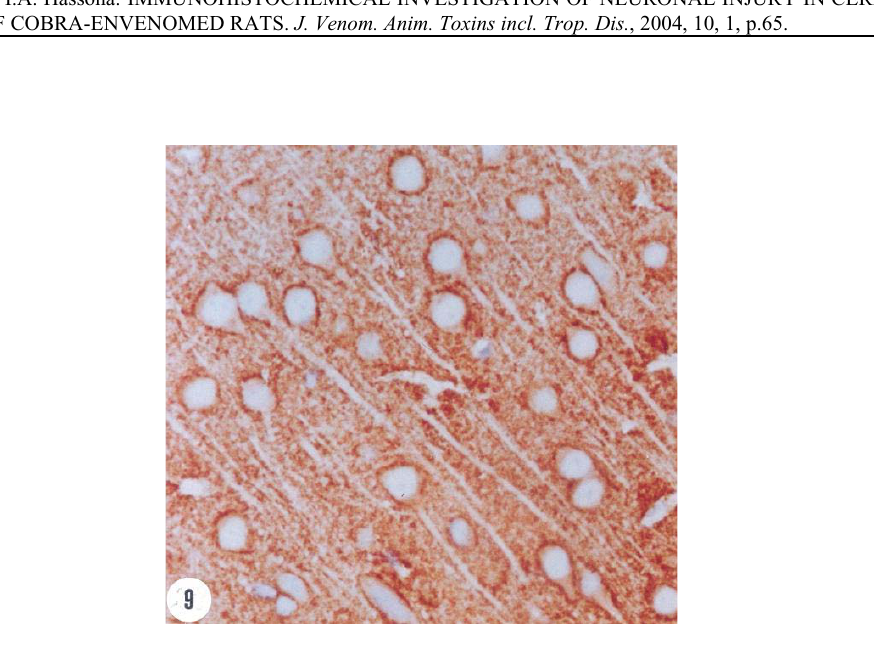
Figure 9. SYN immunoexpression at the periphery of cytons and between neurons of a control cerebral cortex. (X400)